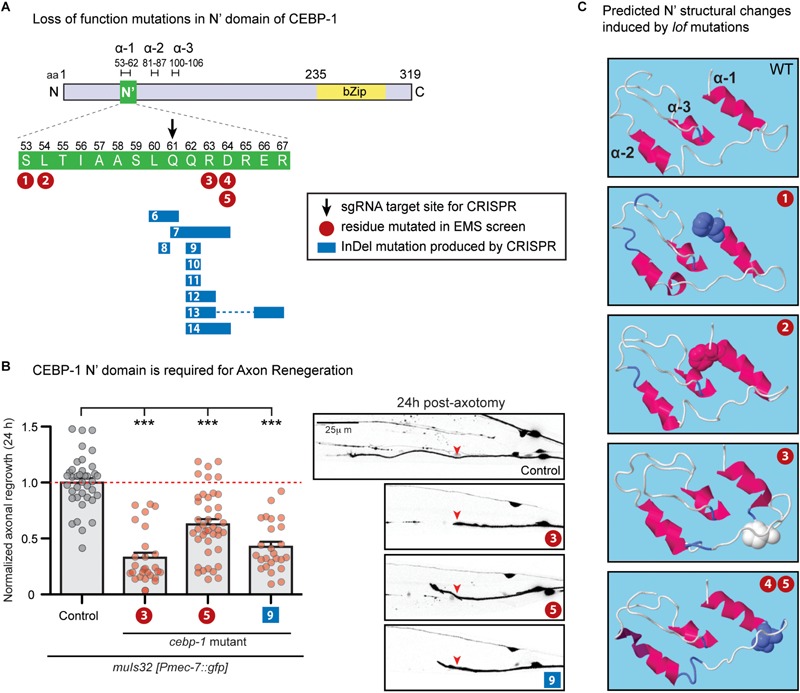
N’ functional domain in CEBP-1 is required for proper axon regeneration and protein structure formation. (A) CEBP-1 N’ domain mutants isolated in several forward genetic screens. Mutations 1–5 are missense mutations isolated in forward genetic screens utilizing EMS as a chemical mutagen. #1, ju1518 S53F; #2, ju1519 L54F; #3, ju634 R63P; #4/5, ju1520/ju1521 D64N. Mutations 6–14 were isolated in a forward genetic screen utilizing targeted CRISPR/Cas9 mutagenesis. The site targeted for double stranded DNA breakage is marked with a black arrow. These mutations do not cause a shift in frame, only add and/or delete amino acids adjacent to the cut site. #6, ju1588Δ (L60, Q61); #7, ju1587Δ(Q61, Q62, R63, D64) +HH; #8, ju1592 L60[HSTRS]Q61; #9, ju1590ΔQ62; #10, ju1685ΔQ62 +HE; #11, ju1686ΔQ62 +HRG; #12, ju1591Δ(Q62, R63) +RPVTS; #13, ju1586Δ(Q62, R63)+H Δ(E66, R67); #14, ju1589Δ (Q62, R63, D64)+H. (B) PLM axon regrowth 24 h post-axotomy in cebp-1(ju634) mutants in PLM mechanosensory neurons. Length of regrowth was quantified by subtracting the initial length of the axon at 0 h from the length of the axon 24 h after injury. Data are shown as mean ± SEM. One-way ANOVA followed by Tukey’s multiple comparison test. ∗∗∗p < 0.001. Column 1: control, CZ10969 [muIs32]; Column 2: CZ21689 [muIs32; cebp-1(ju634)] (#3); Column 3: CZ27204 [muIs32; cebp-1(ju1521)] (#5); Column 4: CZ27464 [muIs32; cebp-1(ju1590)] (#9). Right: representative images of PLM axons 24 h post-axotomy. Red arrowhead, site of axotomy. (C) Alteration of predicted alpha helices structure upon cebp-1 N’ mutations based on RaptorX. The S53F mutation (#1) makes a predicted break in α-2, producing two helices. The L54F mutation (#2) makes lengthening of α-1 and α-2, and the R63P mutation (#3) makes lengthening of α-2. The D64N mutation (#4/5) is predicted to cause the additional turn in the C’ end of α-2.